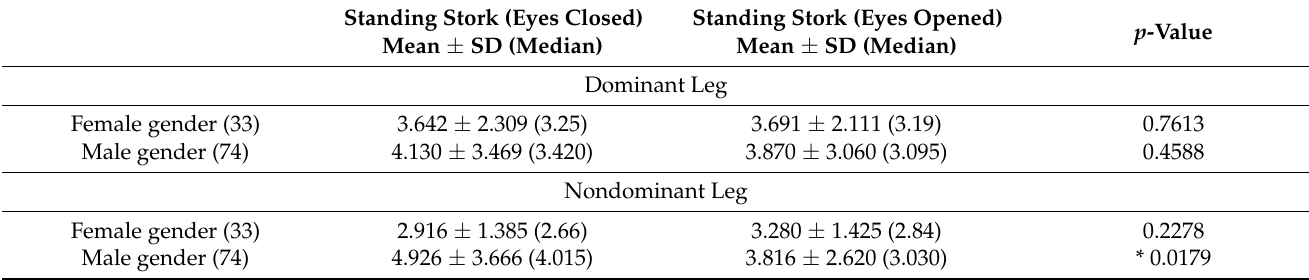
Table 3. Analysis of the medians of the two tests, standing stork (eyes closed/opened) related to gender.